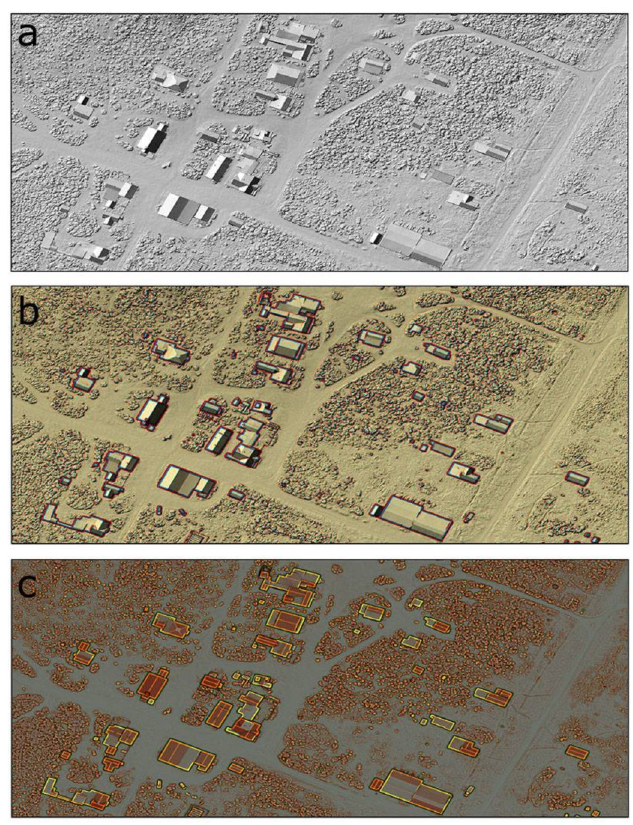
Figure 8. GIS visualizations of the Bodie downtown captured by drone-based IBM in 2020. The figure compares our results obtained using the following techniques: ( a ) Hillshade; ( b ) Local Relief Model; ( c ) our custom Local Relief blending a Slope Map with Local Relief Model. Visualizations by G. Jim é nez